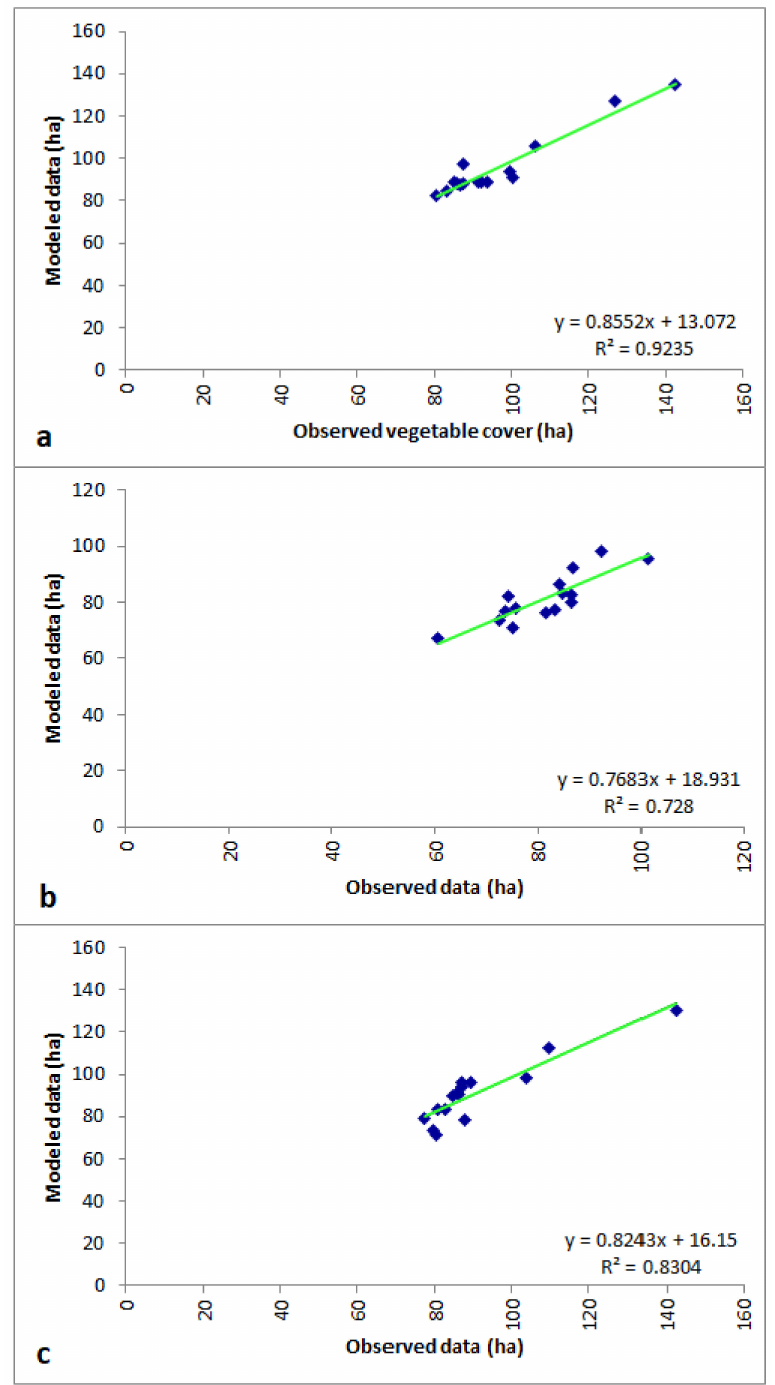
Figure 8. Model validations based on modeled and observed data for the wet period model ( a ), dry period model ( b ), and the annual model ( c